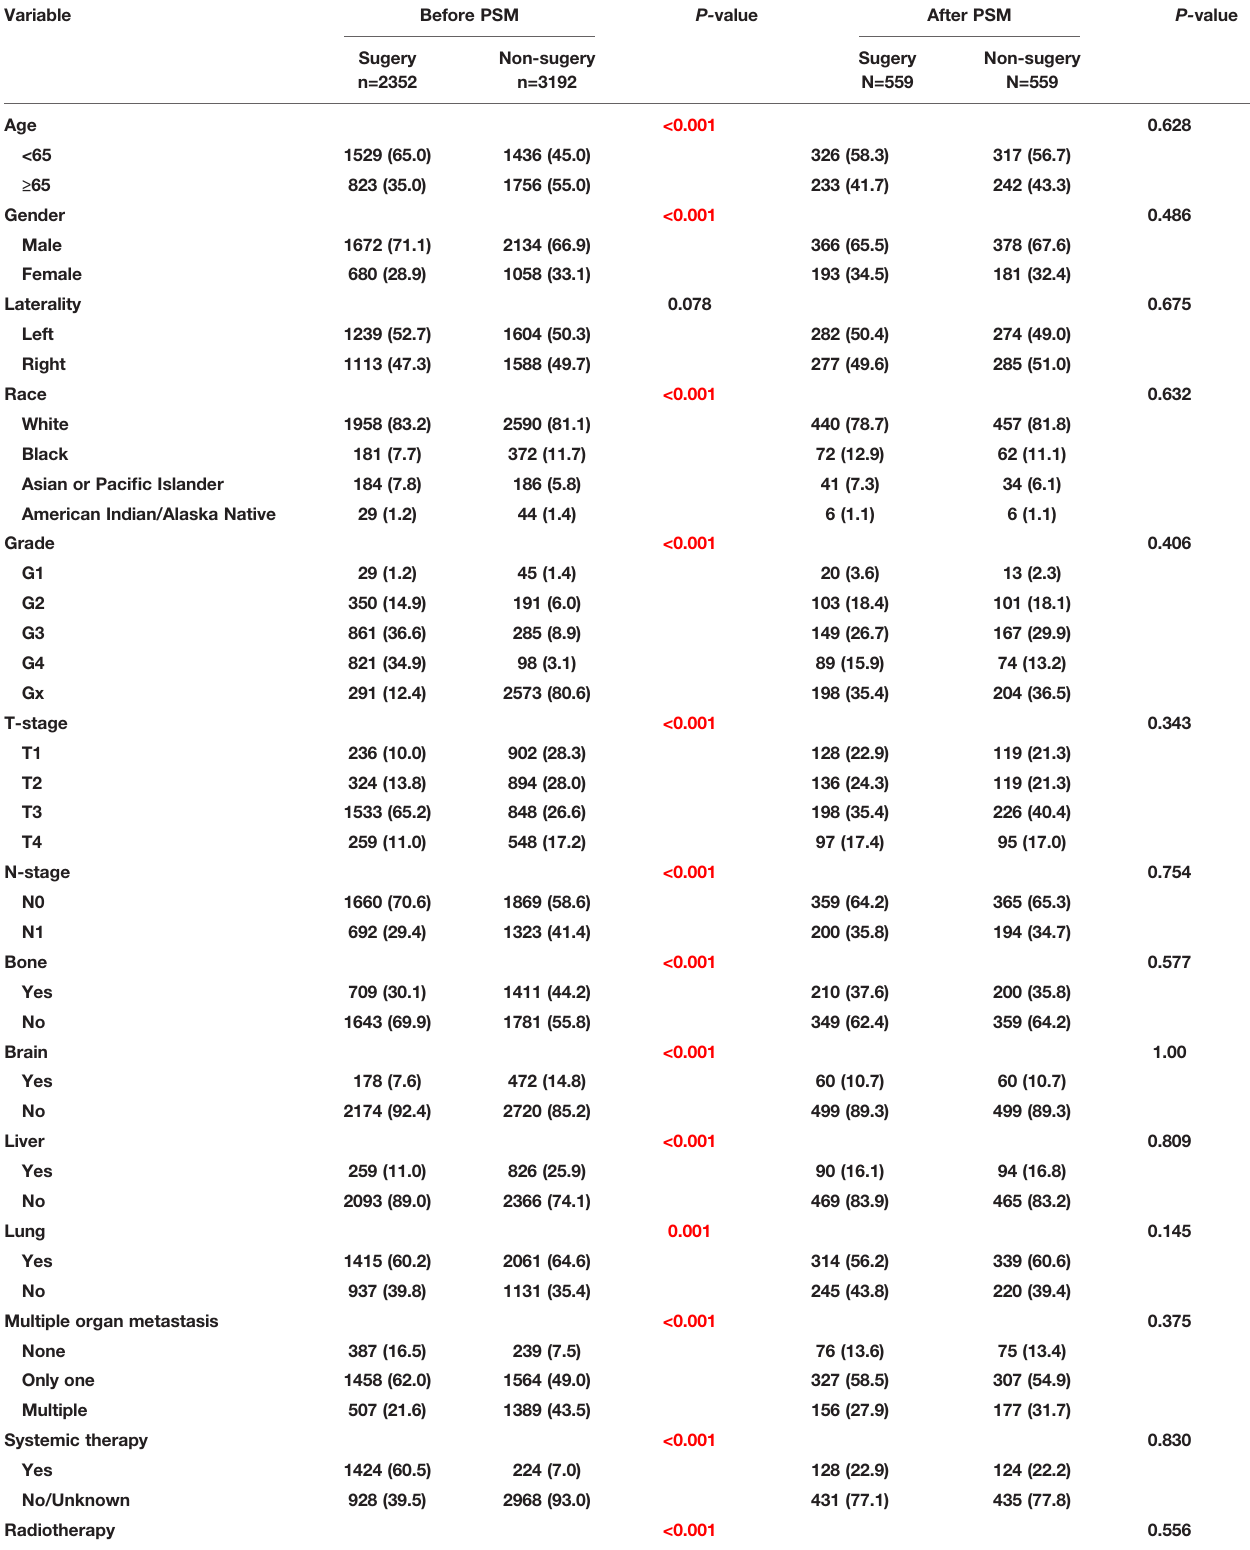
TABLE 2 | Baseline characteristics of the study